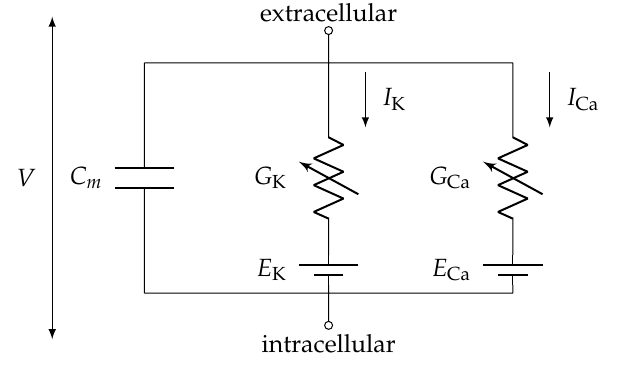
Figure 3. Physical